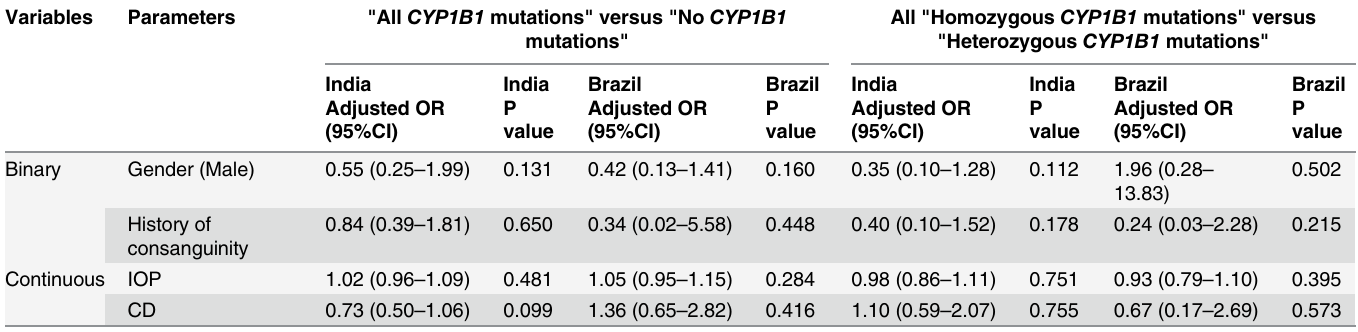
Table 4. Logistic regression showing the adjusted odds ratios for the binary and continuous variables for different mutation categories in the Indi- an and Brazilian cohorts. Variables